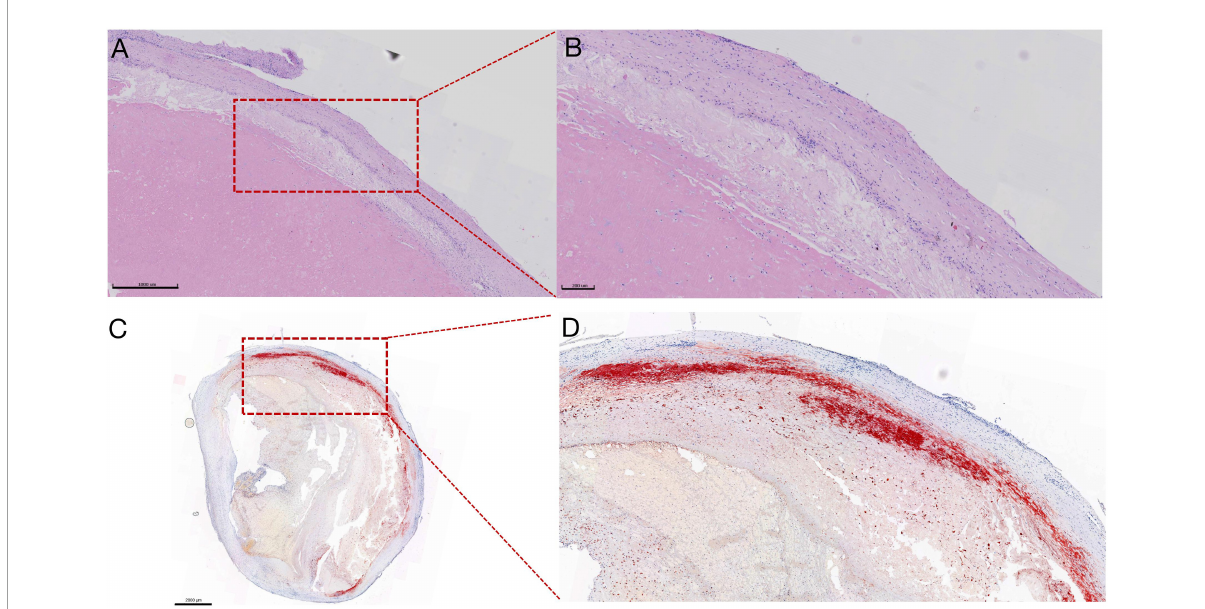
FIGURE2 Representative images of atherosclerotic lesions in PEA specimens revealed by H&E and Oil-Red-O staining. (A) Irregular-shaped cholesterol crystallization and the cluster of foam cells derived from macrophages engulfing the lipid, scale bars: 1,000 µ m. (B) Magnification of the picture on the left. (C) The bright red area shows apparent lipid deposition, localized inside the neointima, and adjacent to the thrombotic materials, scale bars: 2,000 µ m. (D) Magnification of the picture on the